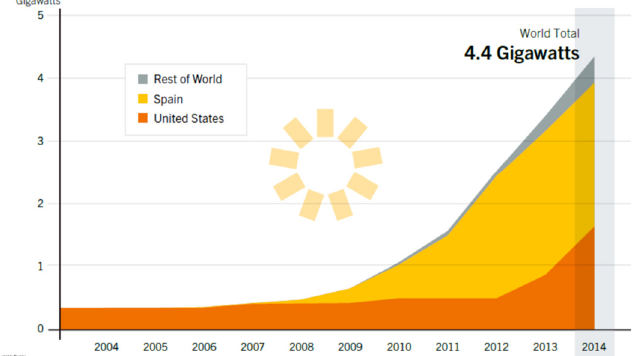
Fig. 1. Accumulated capacity installed [1].